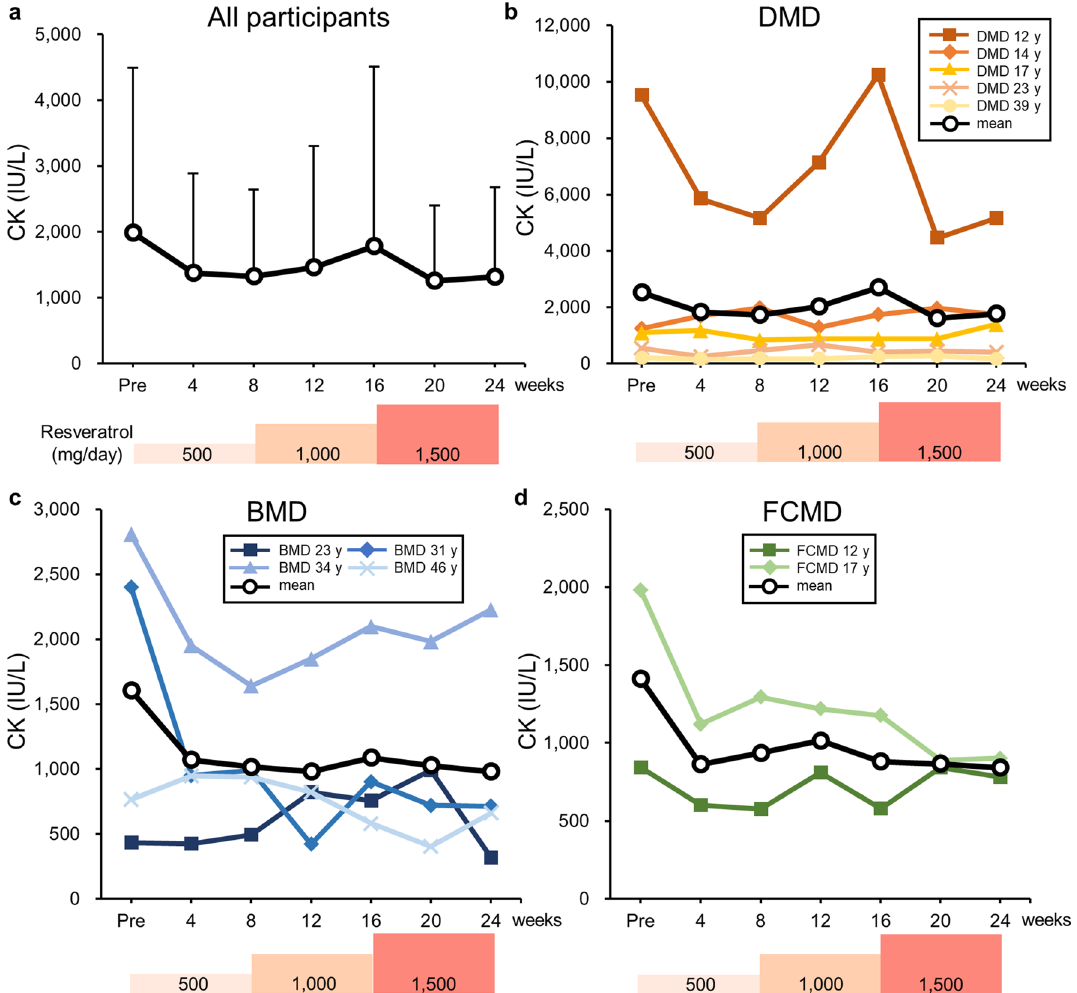
Figure 4. Serum creatine kinase (CK) levels following resveratrol administration. ( a ) Mean serum CK levels of all participants with standard deviation. ( b–d ) Change in CK activity in each patient with ( b ) Duchenne, ( c ) Becker, or ( d ) Fukuyama congenital muscular dystrophy. Black lines show the mean CK